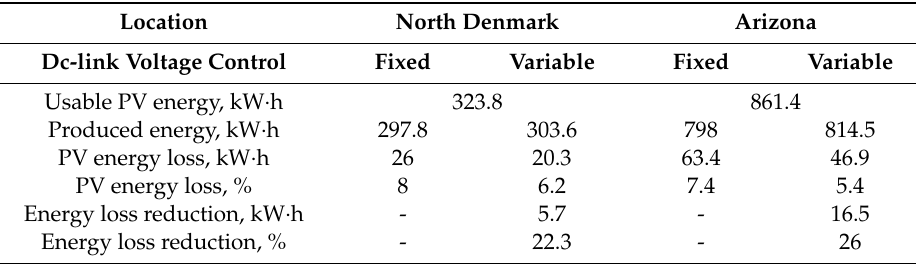
Table 4. Annual energy production simulation